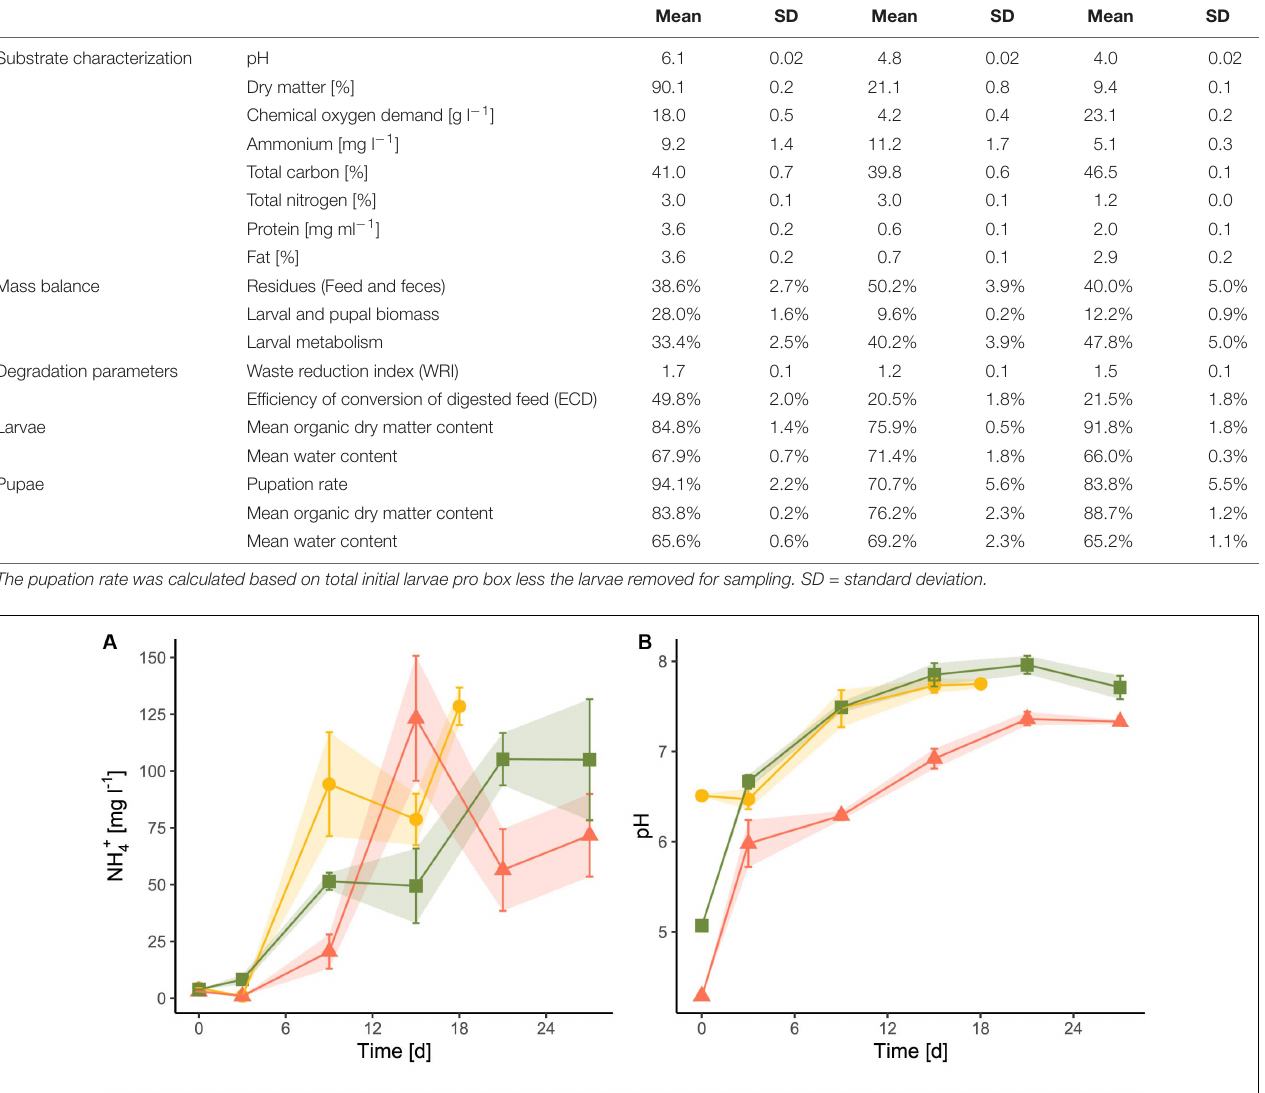
Diet Chickenfeed